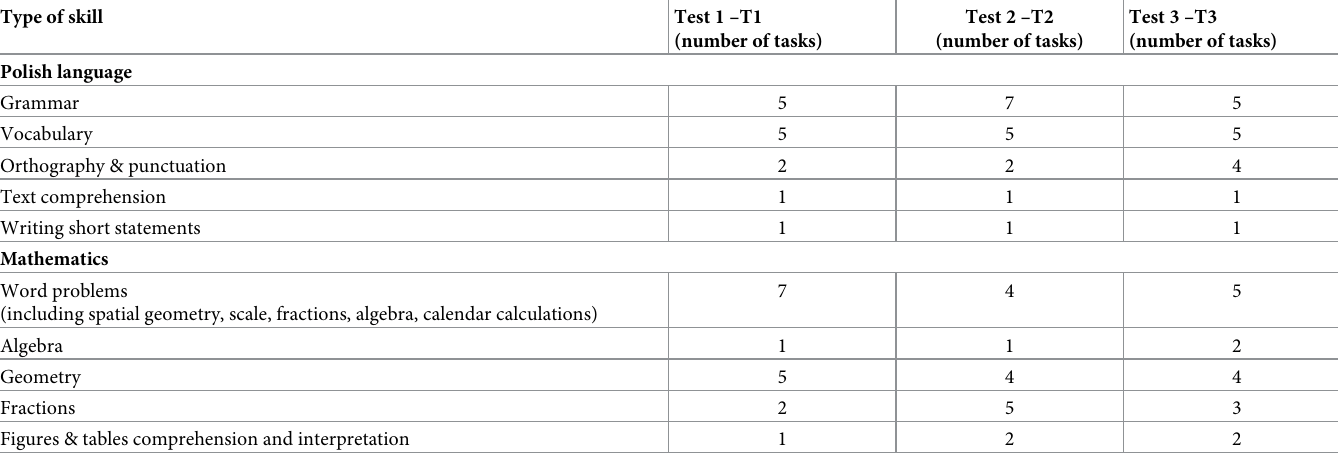
Table 2. Types of tasks across the three tests in Polish language and